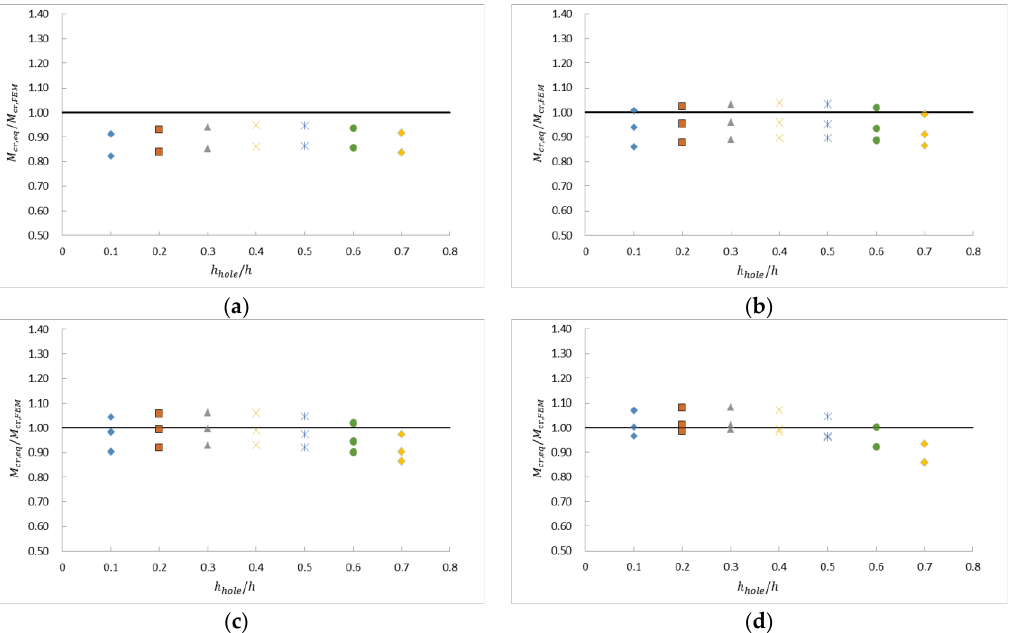
Figure 11. Comparison of critical moments of distortional buckling between formula and FEM. ( a ) Section A (h = 180, b = 60, c = 20, t = 2.0, and e = 9). ( b ) Section B (h = 200, b = 70, c = 20, t = 2.2, and e = 9). ( c ) Section C (h = 240, b = 75, c = 20, t = 2.5, and e = 9). ( d ) Section D (h = 300, b = 80, c = 20, t = 3.0, and e = 9).